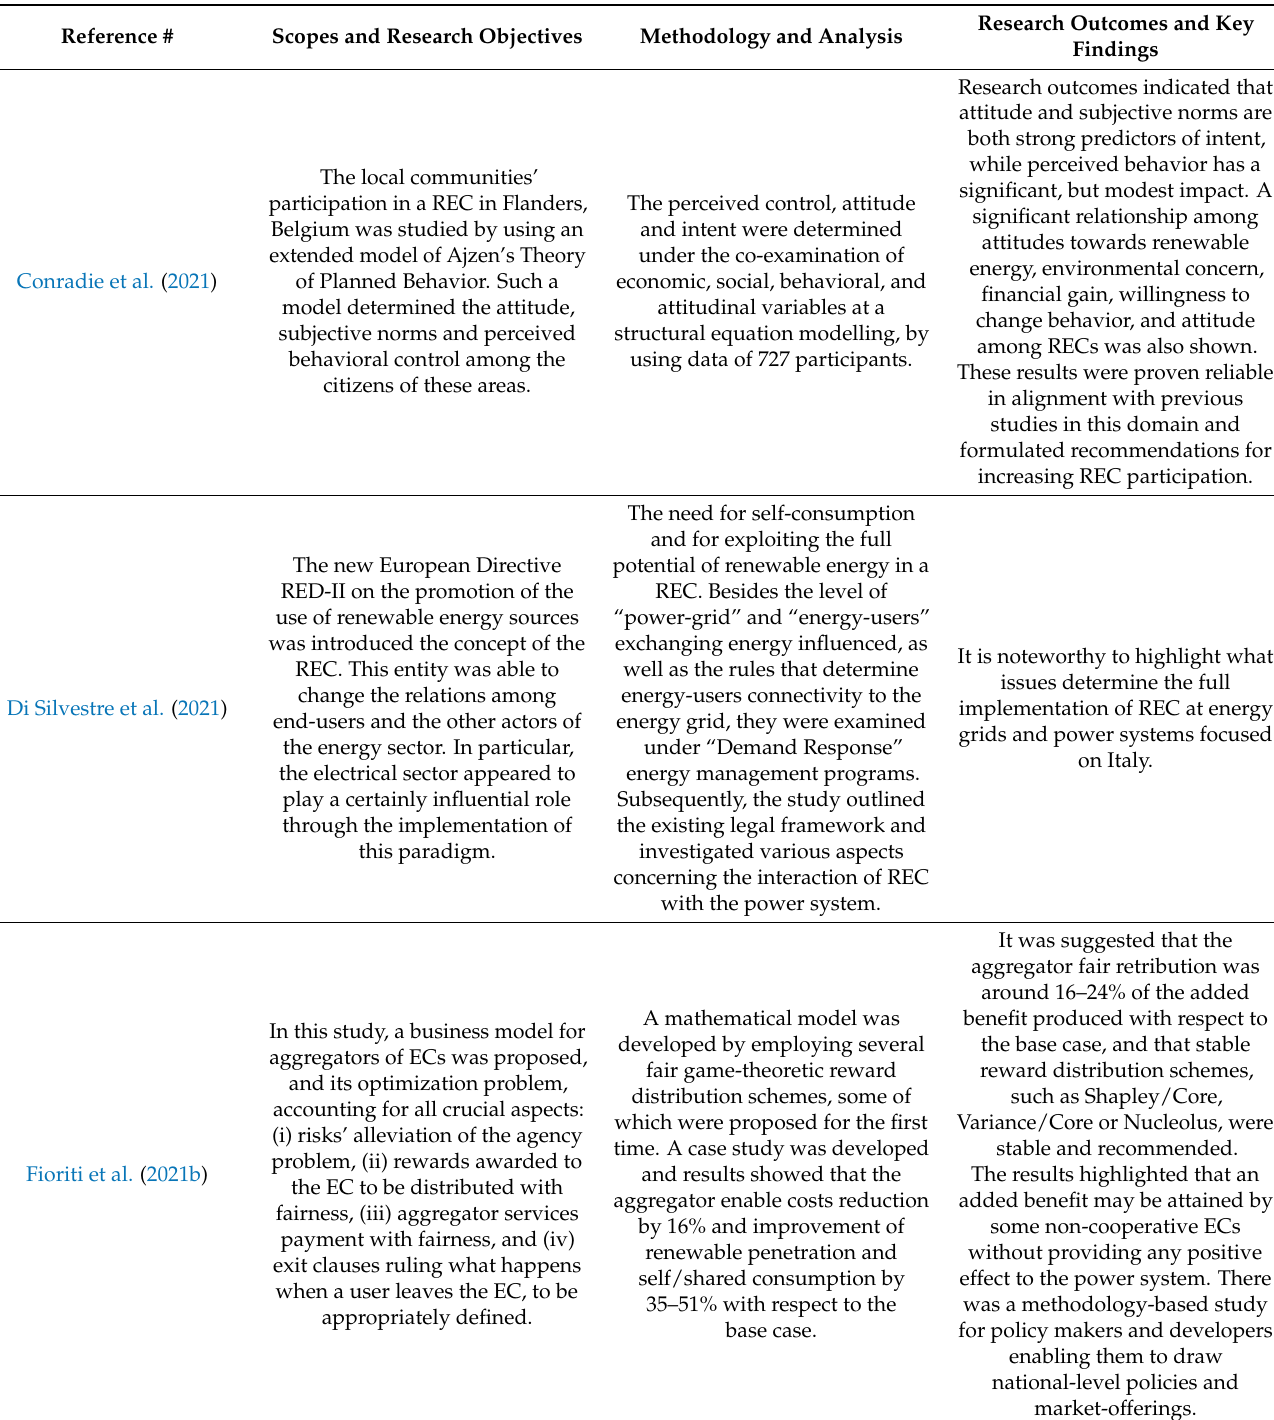
Table 5. The context of renewables—Group 1 (studies are presented in reverse chronological order and in last name of first author alphabetical